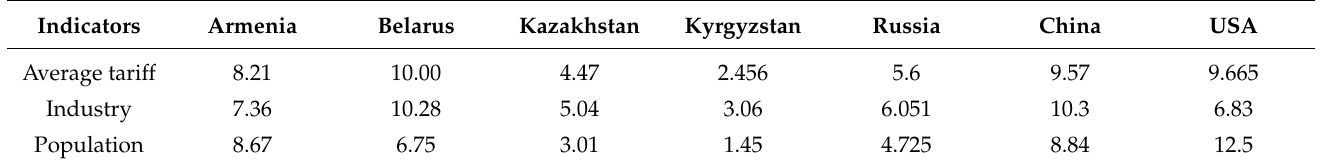
Table 4. Electricity tariffs in 2020, USD